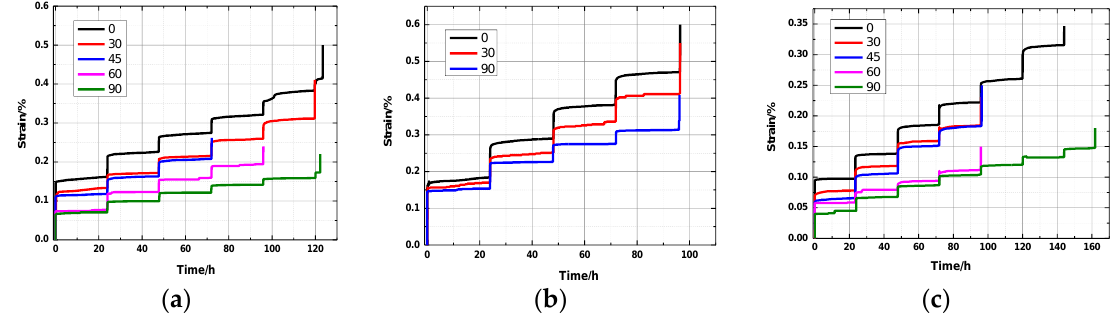
Figure 16. Strain with time for different bedding angles under different states: ( a ) natural state; ( b ) saturated state; and ( c ) dry state.